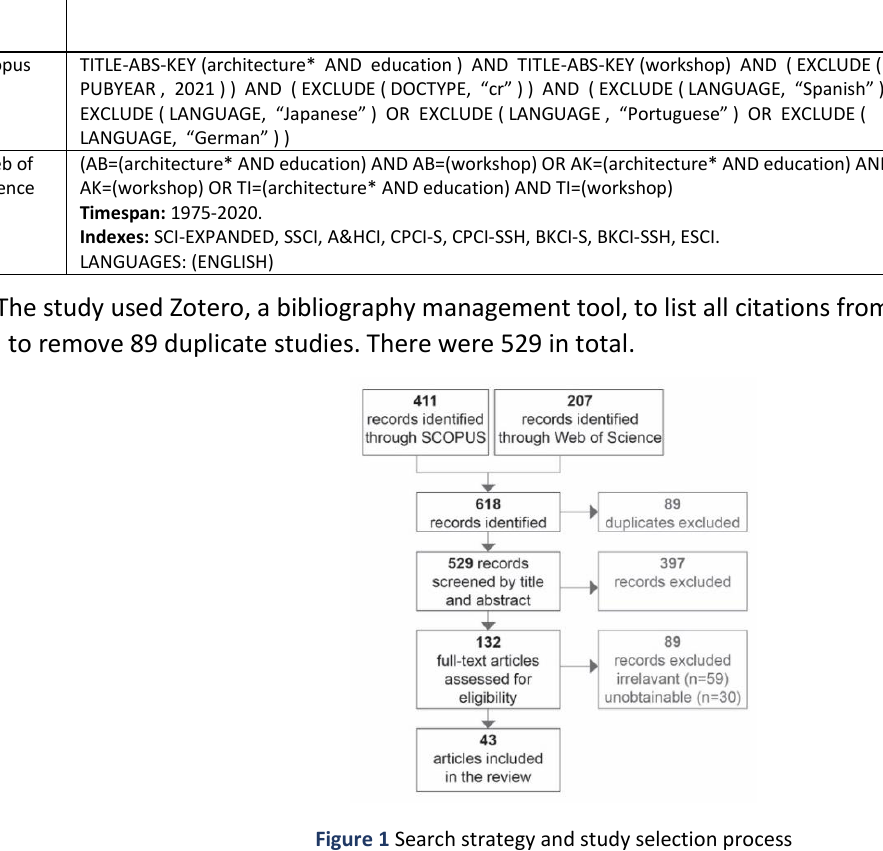
Figure 1 Search strategy and study selection